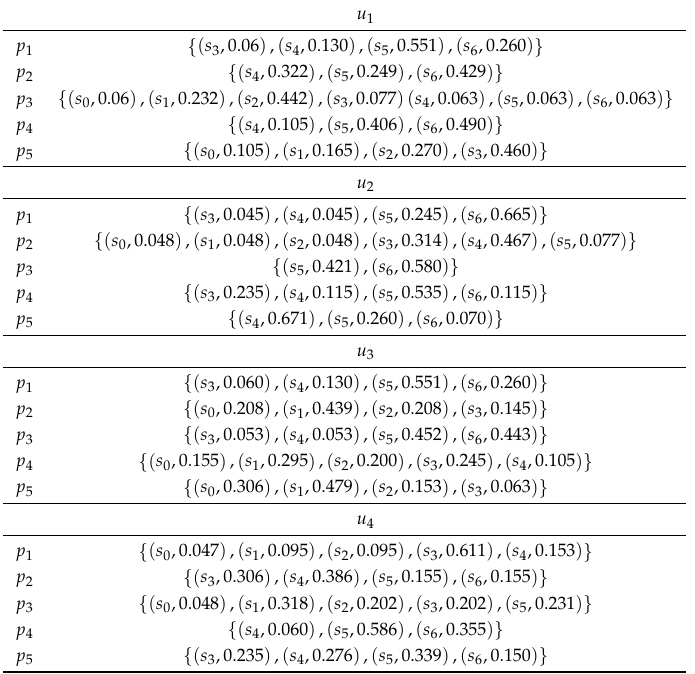
(cid:105) (cid:104) P ij . H S 5 × 4